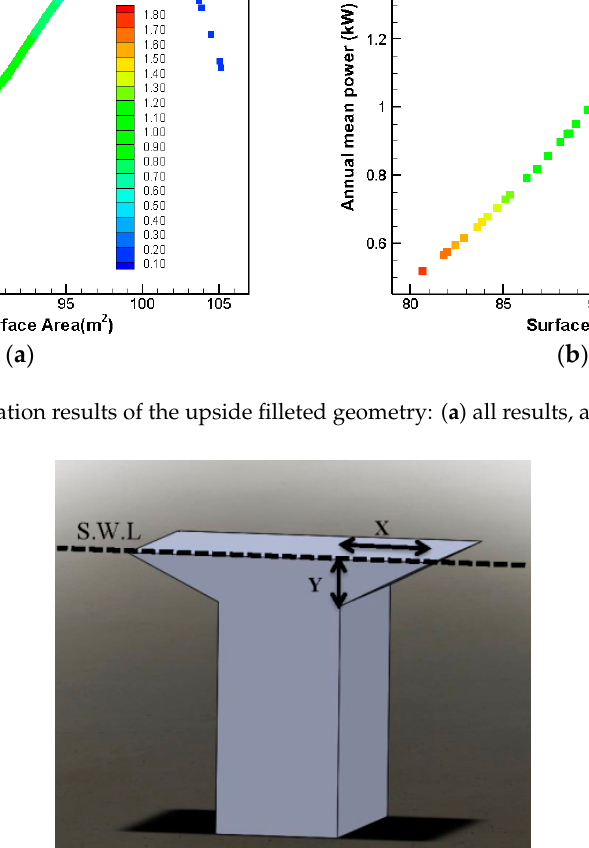
Figure 23. Description of the upside chamfered shape.